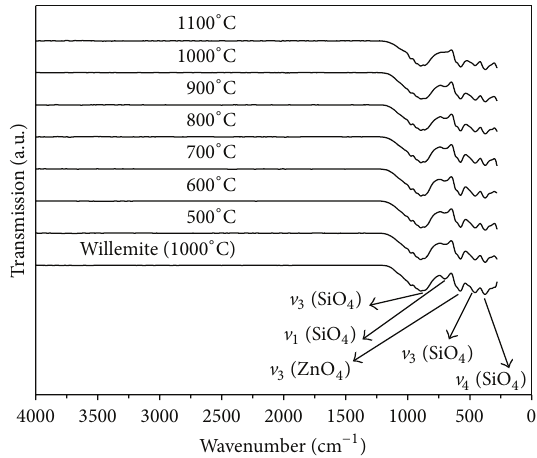
Figure 2: FTIR spectra of the willemite-based glass-ceramic sam- ples doped with 3wt% Er 2 O 3 sintered at the temperature of 500– 1100 ∘ C for